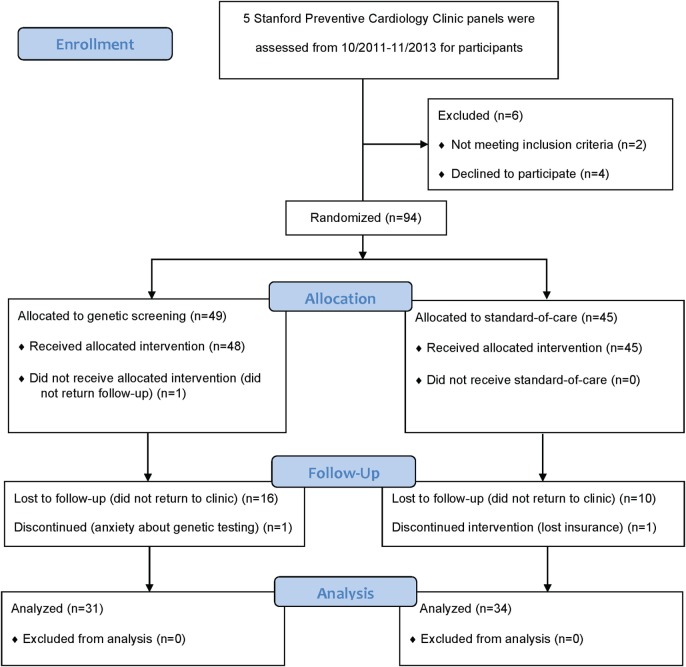
CONSORT flow diagram.